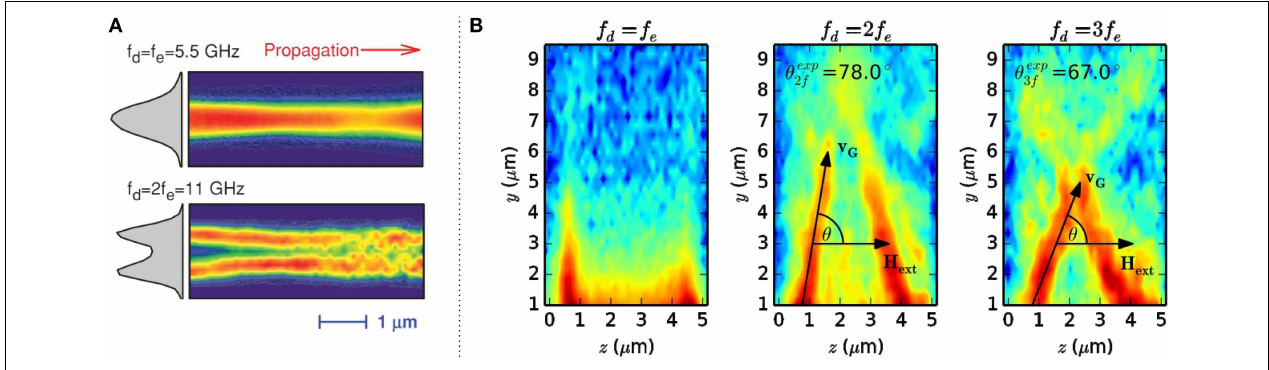
FIGURE 9 | (A) Top: Intensity profile of the spin-wave mode directly excited by an external microwave signal. Bottom: Spin-wave mode at twice the excitation frequency excited by the nonlinear generation of higher harmonics. Taken from Demidov et al. [93]. (B) Intensity profiles of a localized edge mode